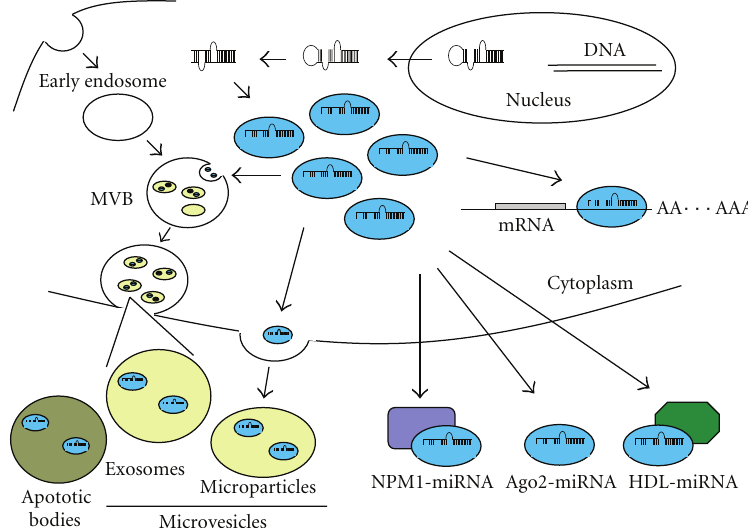
Figure 3: Pathways involved in miRNAs secretion. Extracellular miRNAs (circulating miRNAs) are secreted by incorporation into RNA binding protein, such as Ago2, HDL, and NPM1, or packaged into microvesicles (MVs), including exosomes, microparticles, and apoptotic